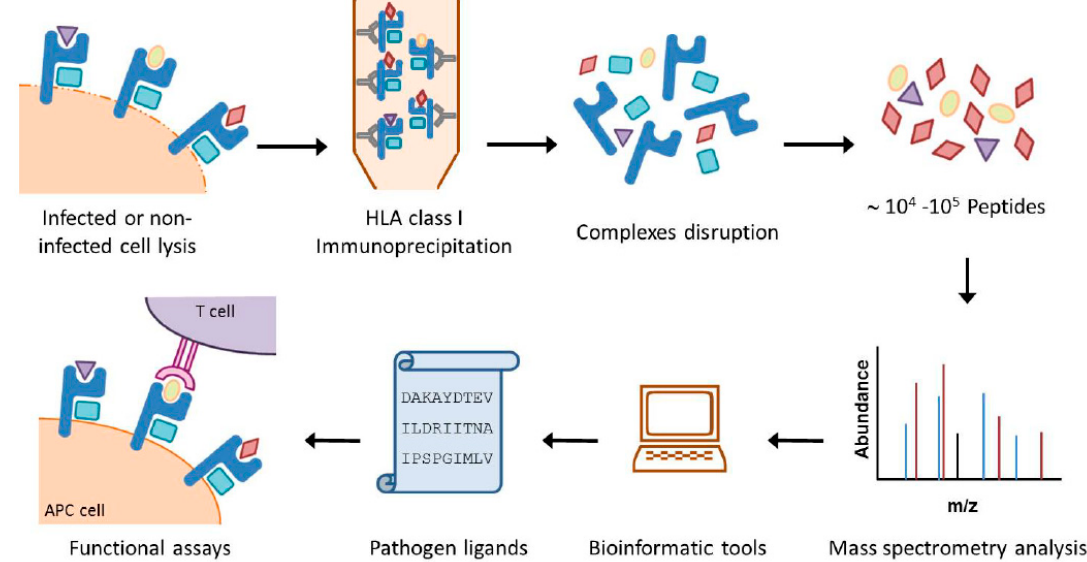
Figure 1. Overview of the HLA immunoproteomic approach. Both large amounts of pathogen-modified and healthy cells expressing the HLA class I or II molecules of interest are lysed in the presence of protease inhibitors. The HLA class I complexes are immunoprecipitated by affinity chromatography with specific anti-HLA mAbs and the HLA/peptide complexes are denatured. The resulting peptide mixtures recovered after an ultra-filtration step are separated by high performance liquid chromatography and analyzed by mass spectrometry. Bioinformatics tools are then used to obtain the sequences of the pathogen ligands. Finally, synthetic peptides, which can be used in functional analysis such as HLA/peptide stability assays, ELISPOT, intracellular cytokine staining assays or cytotoxicity assays, are generated.